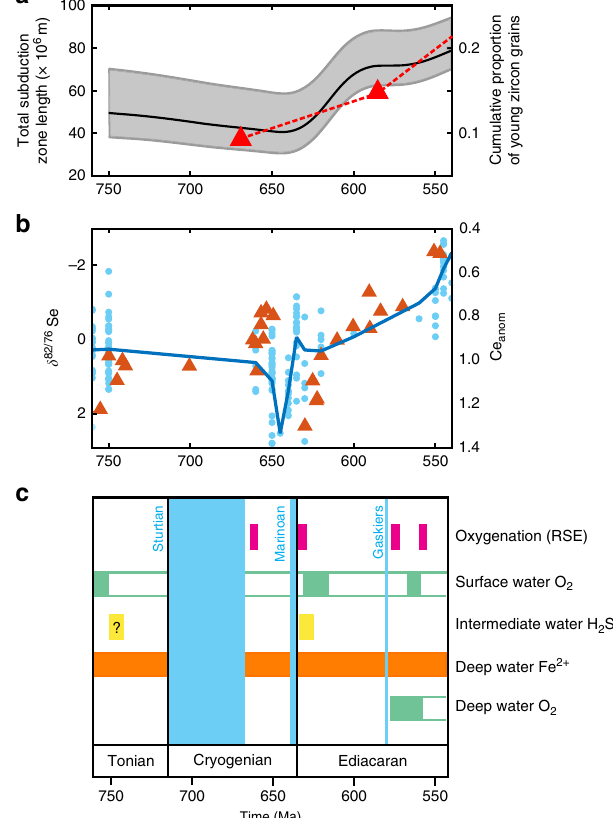
Fig. 1 Tectonic and geochemical evidence for an Ediacaran oxygenation. a Total global subduction-zone length as a proxy for CO 2 input rate, derived from the PALEOMAP project 37 . Error estimations in grey based on observations, timing of collisions and relative plate motions (see Mills et al. 37 Methods). Also shown are the cumulative proportion of young zircon grains (red triangles), indicative of continental arc environments 33 . b , c Proxy compilations for the oxygenation state of the Neoproterozoic ocean: b Less positive selenium isotope ratios recorded in marine shales 15 ( δ 82 / 76 Se; red triangles) indicate more oxic conditions in the global ocean. Stronger negative cerium anomalies recorded in marine cements 20 (Ce anom ; pale blue dots), de fi ned as Ce anom < 1, are indicative of more oxygenated regional to basin-scale conditions (the blue line is a fi t through the Ce anom data). Both proxies suggest a trend towards more oxygenated ocean conditions during the Ediacaran period. c A summary of redox sensitive element (RSE; magenta) enrichment data (Mo, U, Re, V, Cr) from black shales, indicating intervals of widespread ocean oxygenation 16,17,22,23